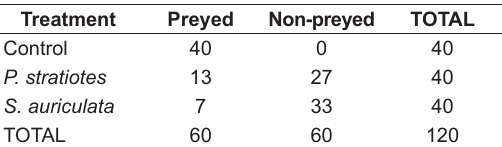
Table 2. Predation on Chironomid in the differents treatments.